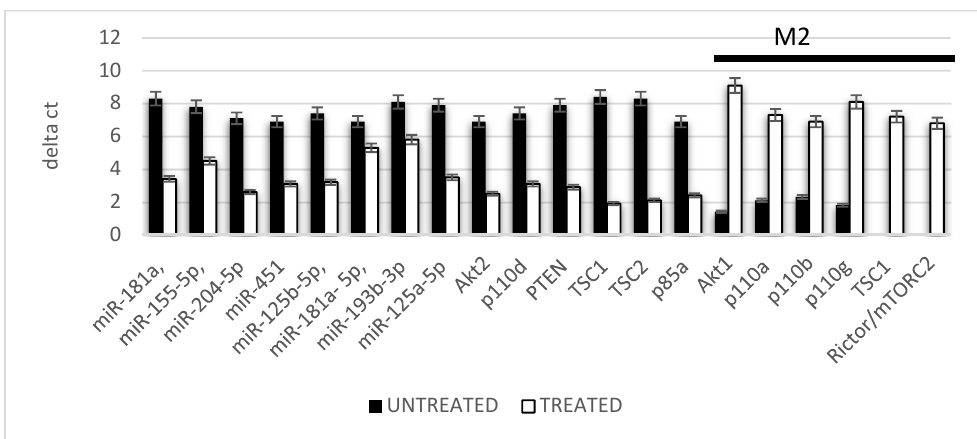
Figure 3. Gene expression related to the macrophages polarization. The genes below the black line are related to the M2 phenotype (M2 ϕ ). All the macrophages were cultured in the presence of an inflammatory condition; the black bars in absence of the CMF and the white bars in the presence of the CMF.